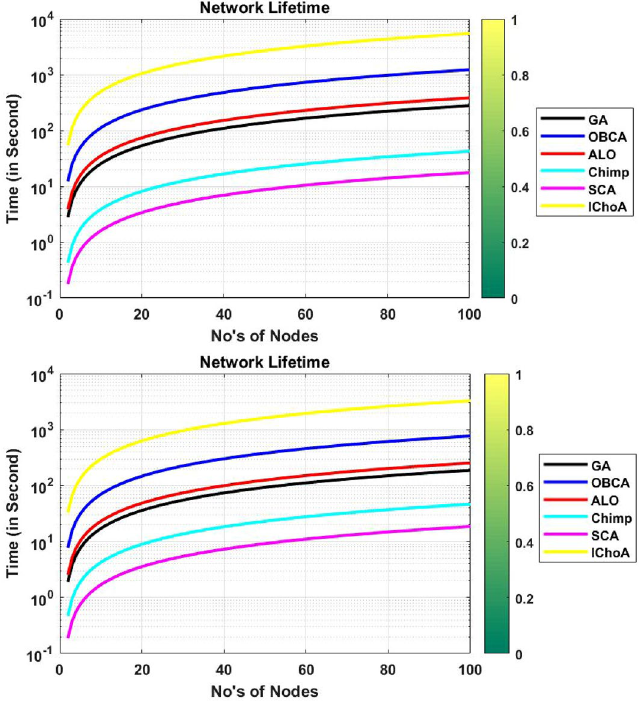
Figure 11. Network life graphs of metaheuristics on functions F 2 and F 6